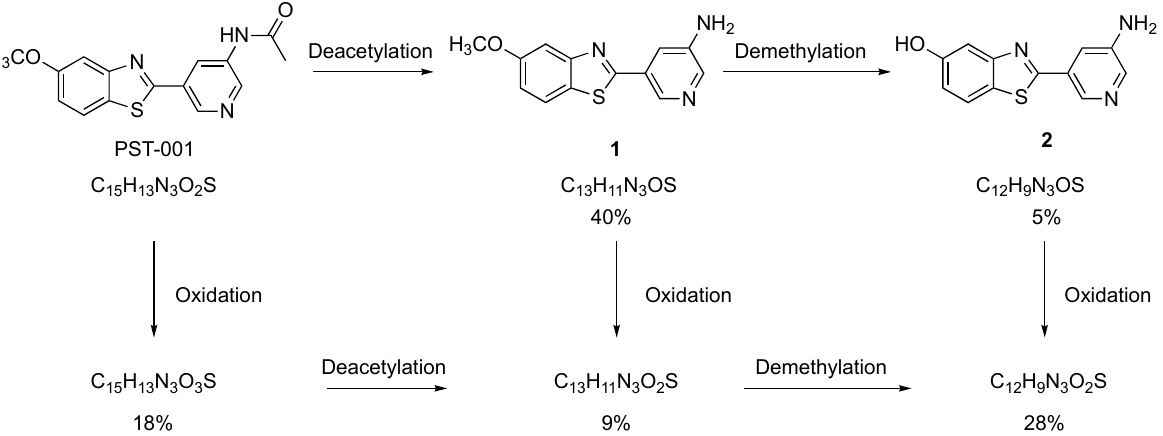
Figure 5. Identified metabolic pathways of PST-001. The percentages represent a snapshot of the distribution of the metabolites at a 30% conversion of PST-001.